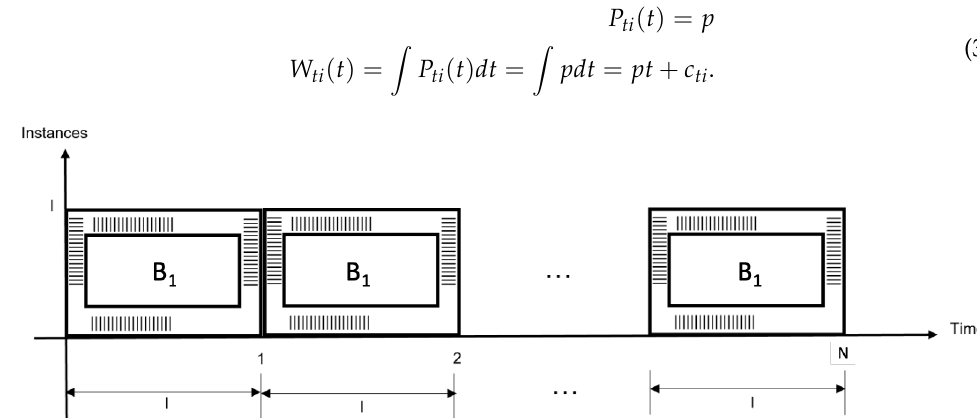
Figure 10. Time redundancy requires one module ( B 1 ) to be sequentially executed in N clock cycles. Case (C) Architecture for hybrid redundancy.The proposed hybrid architecture defines ( h ) an instance B that operates several times with the same data block (for example, N times), 1 reporting a greater latency l ( h ) when compared against l . Unlike case A, where N blocks ( h ) are used, this architecture requires only one instance ( B ) to be used during a given time; 1 ( h ) and as opposed to case B, where a block is used several times, block B is occupied just 1 once in this architecture (with its corresponding latency). The corresponding latency is proportional to N , which can be verified in Figure 11.